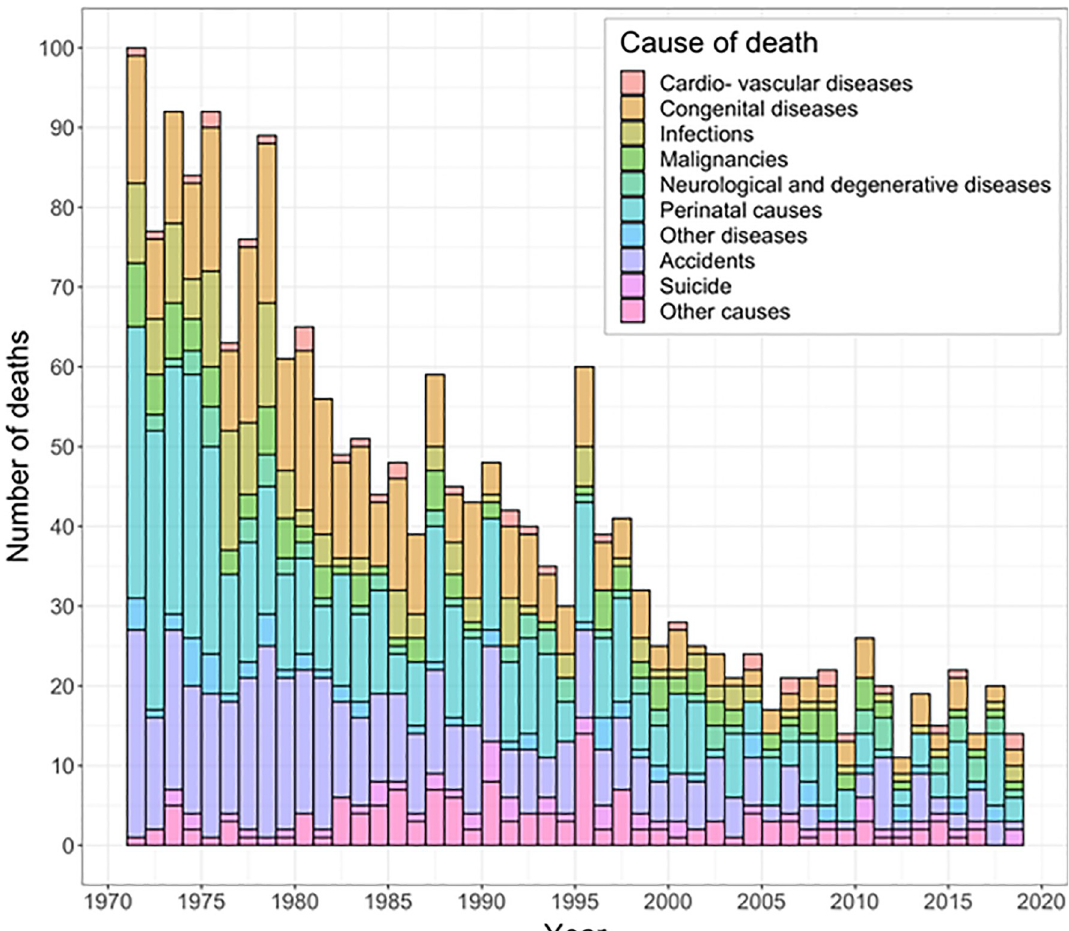
Fig 2. Number of deaths in Icelandic children according to disease categories from January 1 st , 1971 until December 31 st 2018.